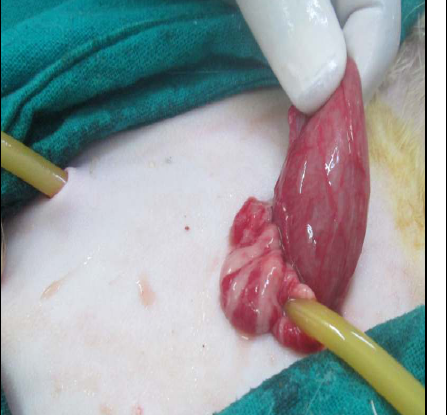
Figure-2: Foleys catheter passed through the subcutaneous tunnel